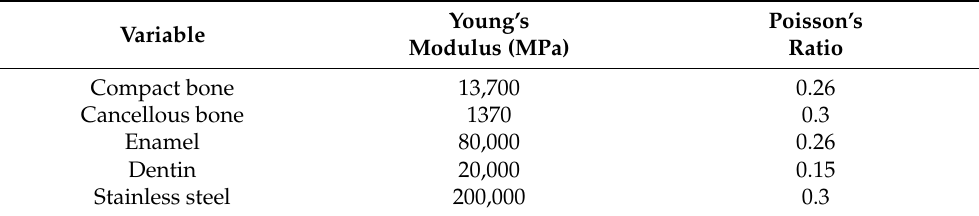
Figure 1. A fragment of the finite element mesh. Table 1. The mechanical properties of the components of the finite element model that was constructed for the present study [27–29].